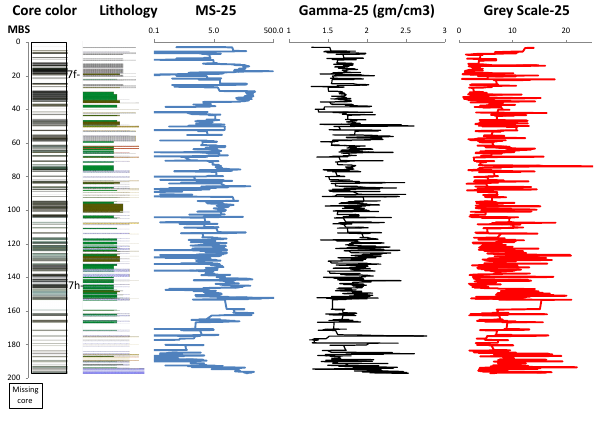
Figure 13. Summary stratigraphy of core HSPDP-MAG14-2A, from the Lake Magadi drilling area, southern Kenyan Rift Val- ley, based on initial core description results. Columns from left to right: core color stratigraphy; lithologic log; see Fig. 5 for the key to lithologies used in all cores illustrated; composite of magnetic susceptibility (MS) log data (25-point running mean smooth) from LacCore Geotek © XYZ point sensor data; composite of induced gamma density log data (25-point running mean smooth, spurious values <1.2gmcm − 3 removed); composite of spectrophotometric grey-scale log data (25-point running mean smooth). All data col- lection, instrumentation, and parameters as in Fig. 5.